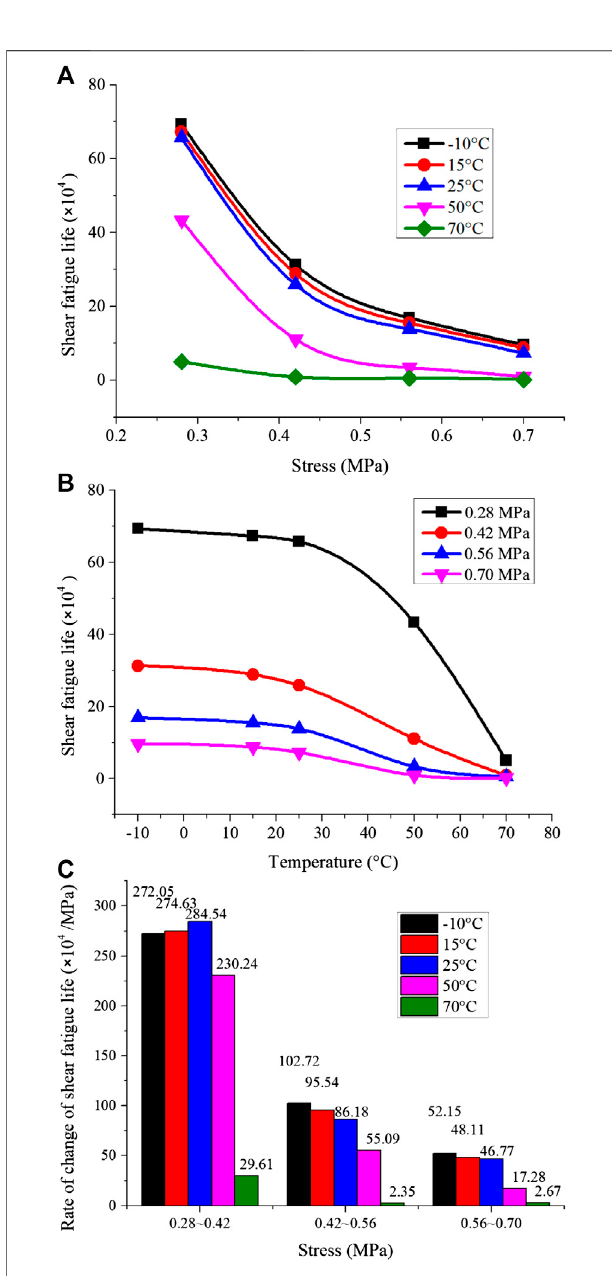
FIGURE 5 | Stress and temperature effect on shear fatigue